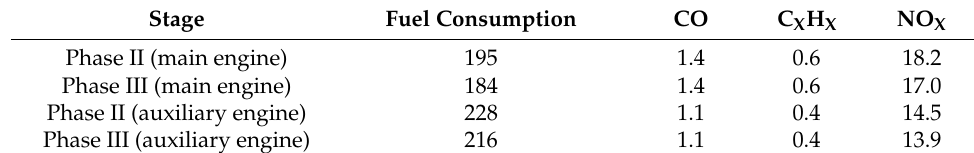
Table 12. Comparison of emission factors for different ECA policies (unit: g/kwh).